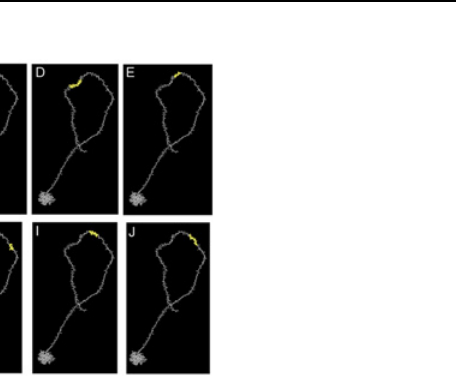
Fig 3. 3D representation of conformational epitopes (A to J) of the highest antigenic nucleocapsid (N) protein of MERS-CoV. The epitopes are represented by yellow surface, and the bulk of the N protein is represented in grey sticks.